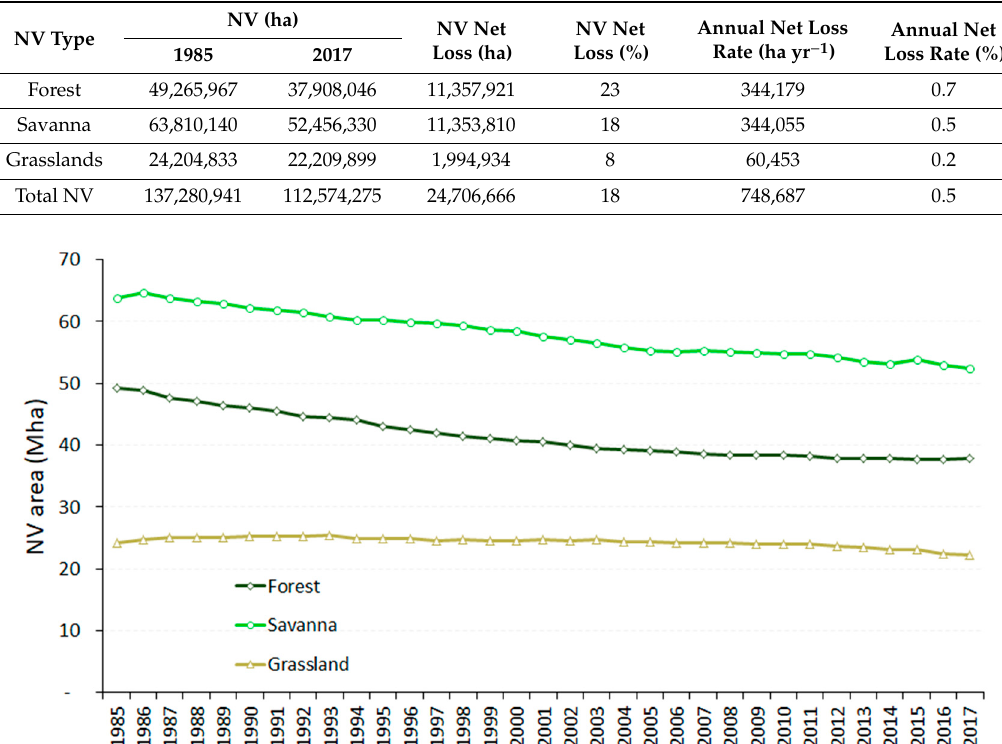
Table 3. Native vegetation area in the Brazilian Cerrado at the beginning (1985) and the end (2017) of the time series, and net loss of native vegetation over the whole period between 1985 and 2017. Absolute and proportional net loss rates per year were also calculated. NV = native Cerrado vegetation.